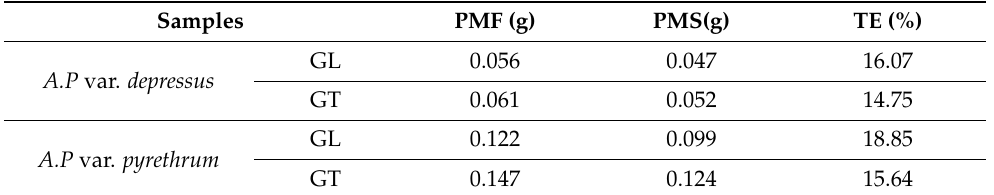
Table 2. Average water content for each seed type (GL: peripheral seeds; GT: central seeds) of A.P var. pyrethrum and A.P var. depressus